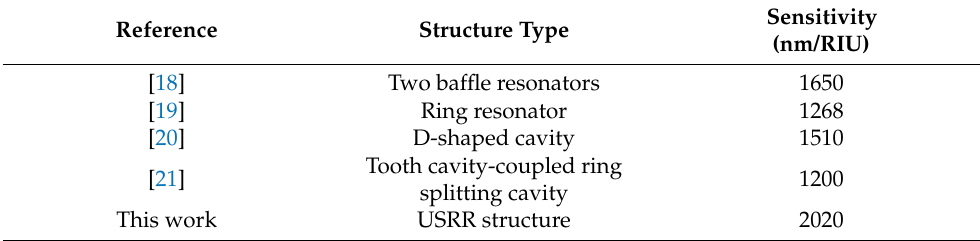
Figure 7. ( a ) Transmission spectra at various refractive indexes; ( b ) Fitting lines of sensitivity at disparate values of refractive indexes. Table 1. Comparisons of the results with recent research.